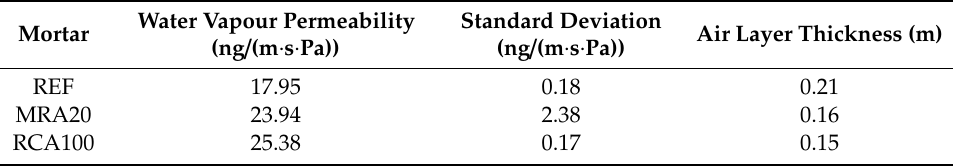
Table 7. Water vapour permeability of the mortars tested.